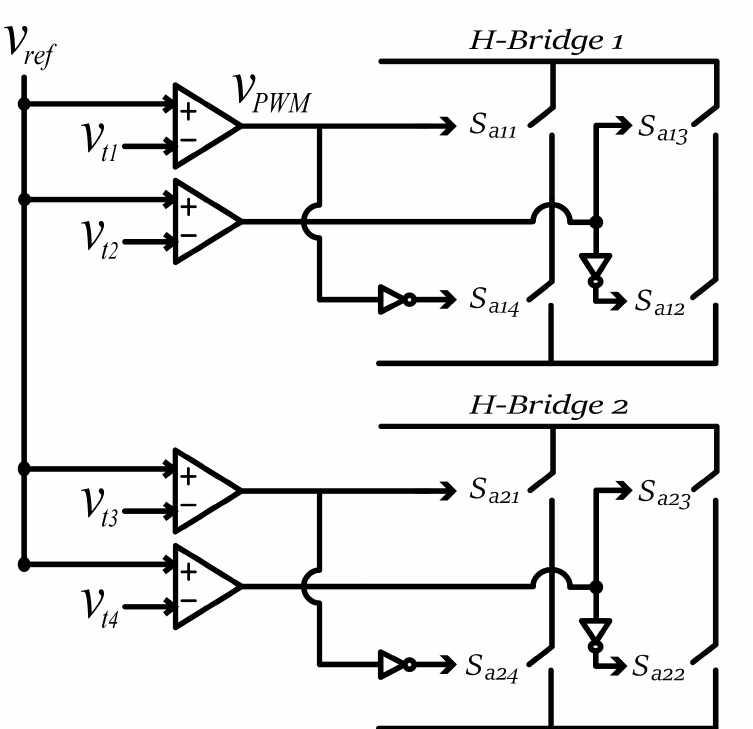
Figure 6. Analog implementation of LS-PWM method.